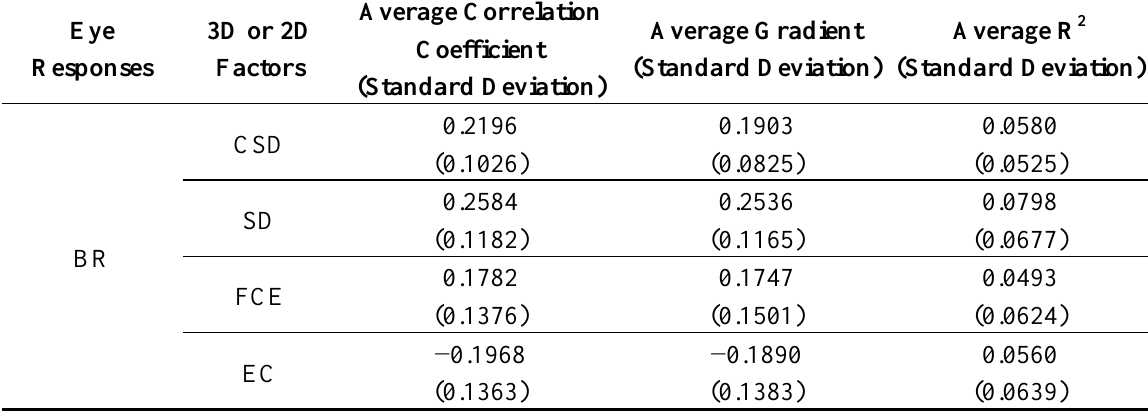
Table 4. Correlation between BR and factors for causing eyestrain on 3D display with experimental sample video by our